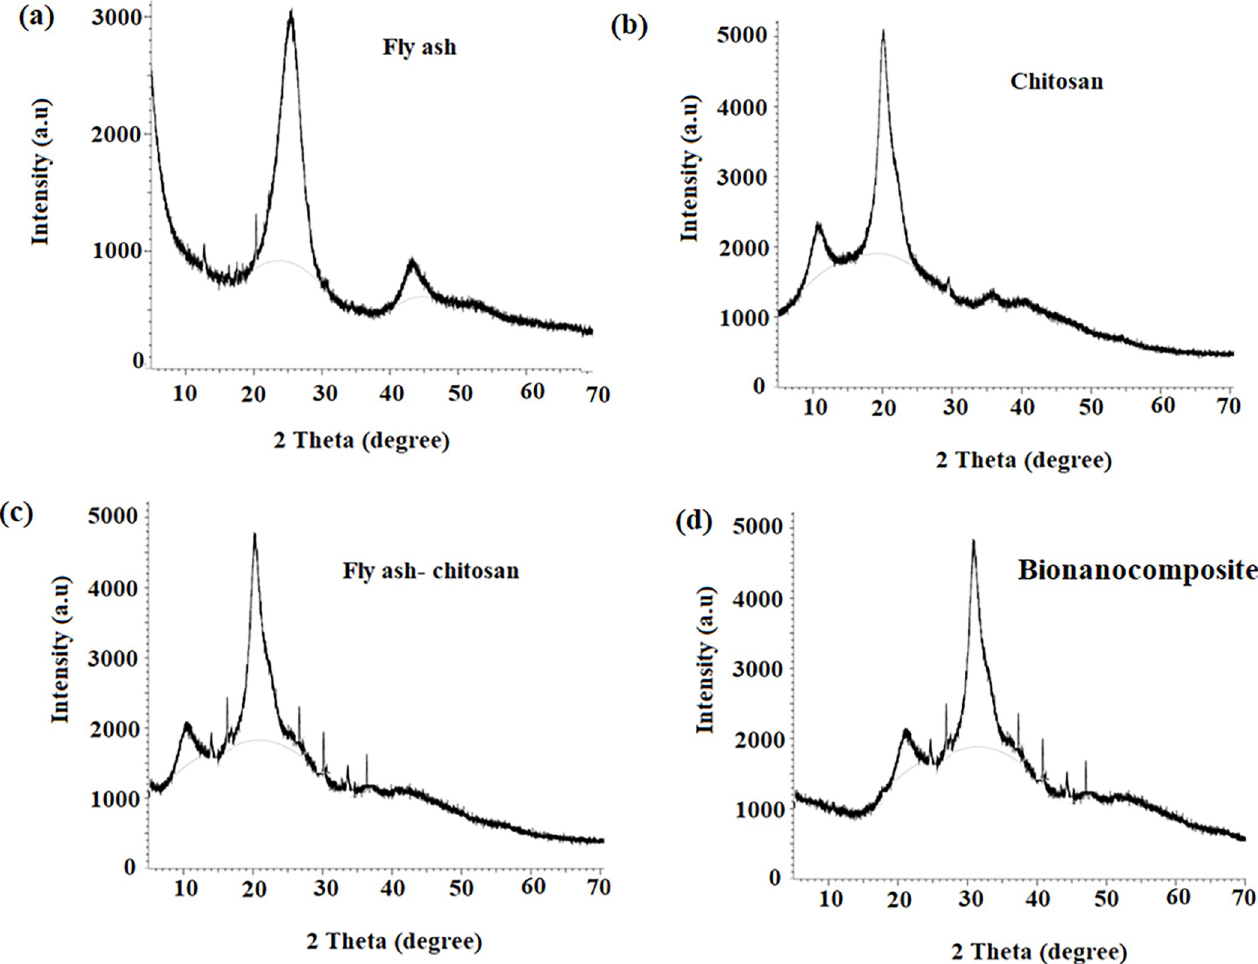
Fig 2. XRD pattens of (a) fly ash, (b) chitosan, (c) fly ash–chitosan nanoparticles, and (d) sunflower–oil–fly ash–CSNPs bionanocomposite film measured at 2 theta degree in the range of